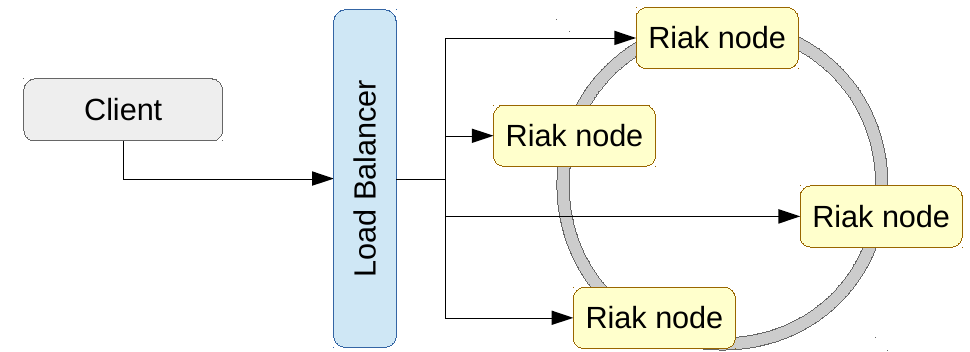
Figure 2. Deployment of a Riak key-value pair